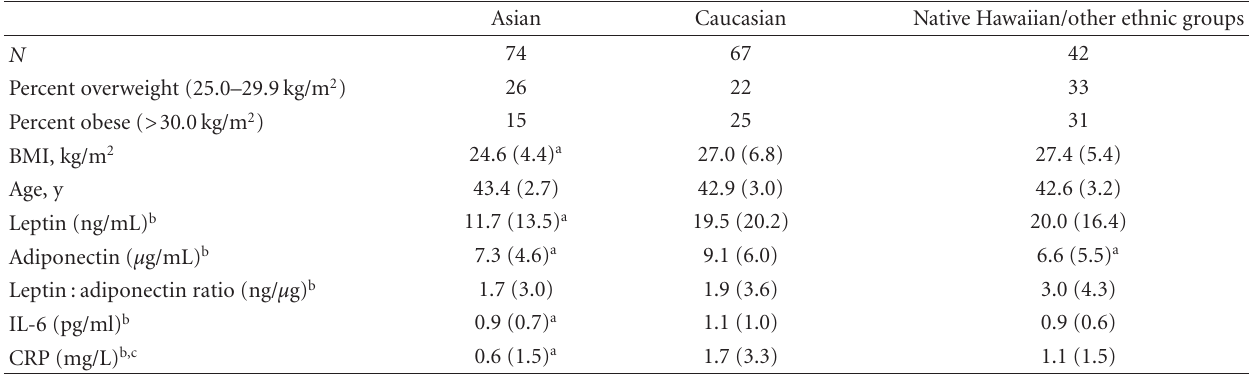
Table 1: Study participant characteristics by ethnicity.